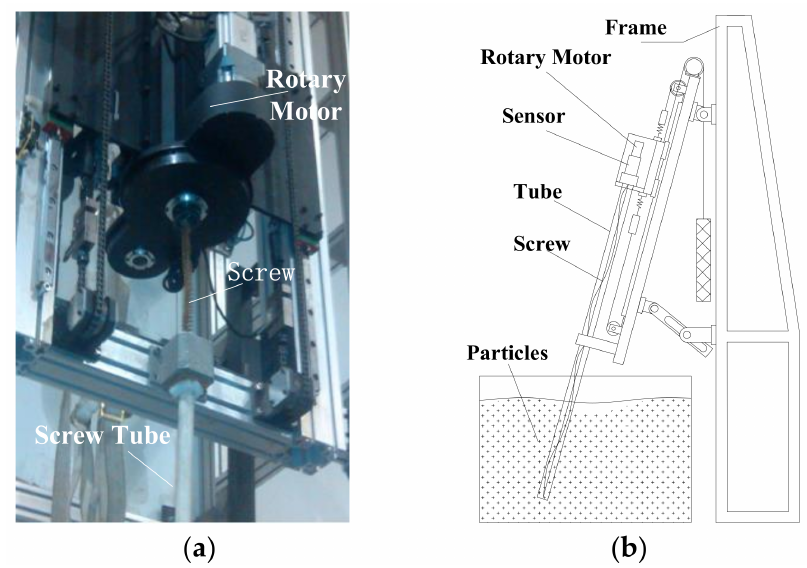
Figure 13. Test bed and parts. ( a ) Test bed. ( b ) Parts of test bed.